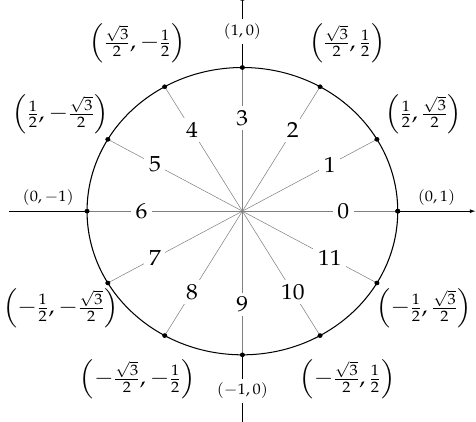
Figure 6. Values assigned to ( moy_sin , moy_cos ) after a trigonometric transformation of the moy feature, where moy ranges from 0 (January) to 11 (December).